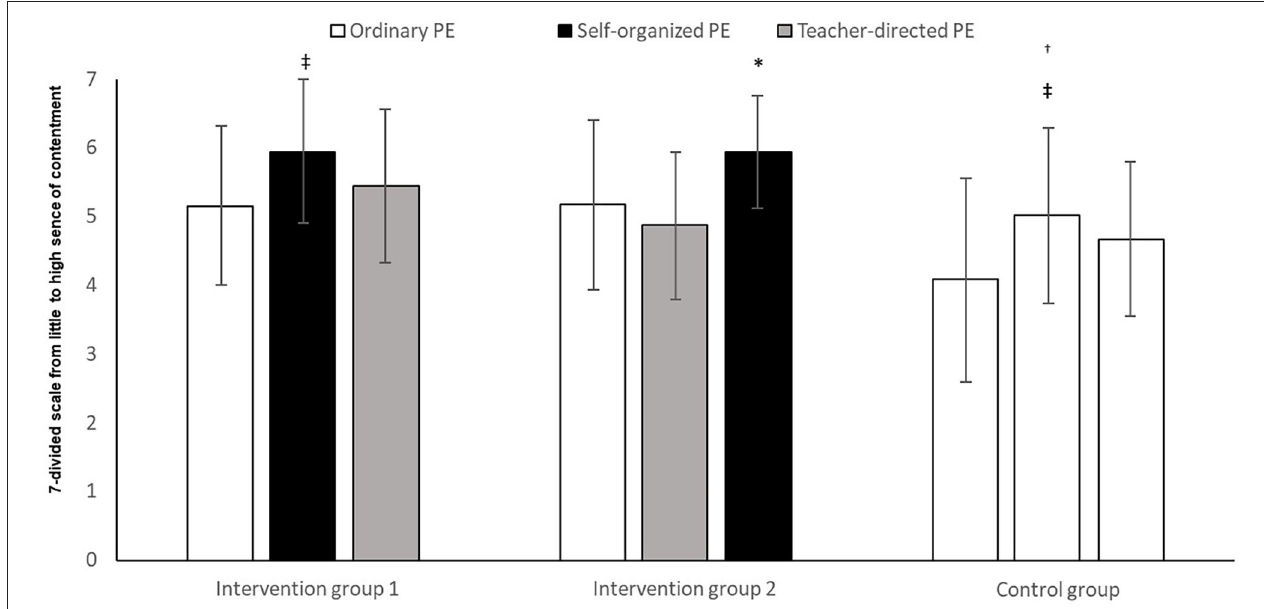
FIGURE 6 | Experience of contentment among pupils after three time periods of ordinary PE, teacher-directed PE, or self-determined PE. *Significantly higher experience of contentment with self-determined PE, compared with ordinary PE and teacher-directed PE ( p < 0.05). ‡ Significantly higher experience of contentment in self-determined PE, compared to ordinary PE ( p < 0.05). † Significantly lower experience of contentment in the control group, compared with intervention groups 1 and 2 ( p < 0.05). ‡ Significantly higher experience of contentment in T2, compared to T1 ( p <